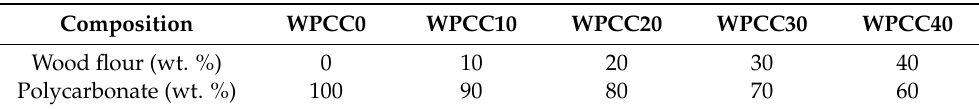
Table 1. Formulations of the wood flour-PC composites. Composition WPCC0 WPCC10 WPCC20 WPCC30 WPCC40 Wood flour (wt. %) 0 10